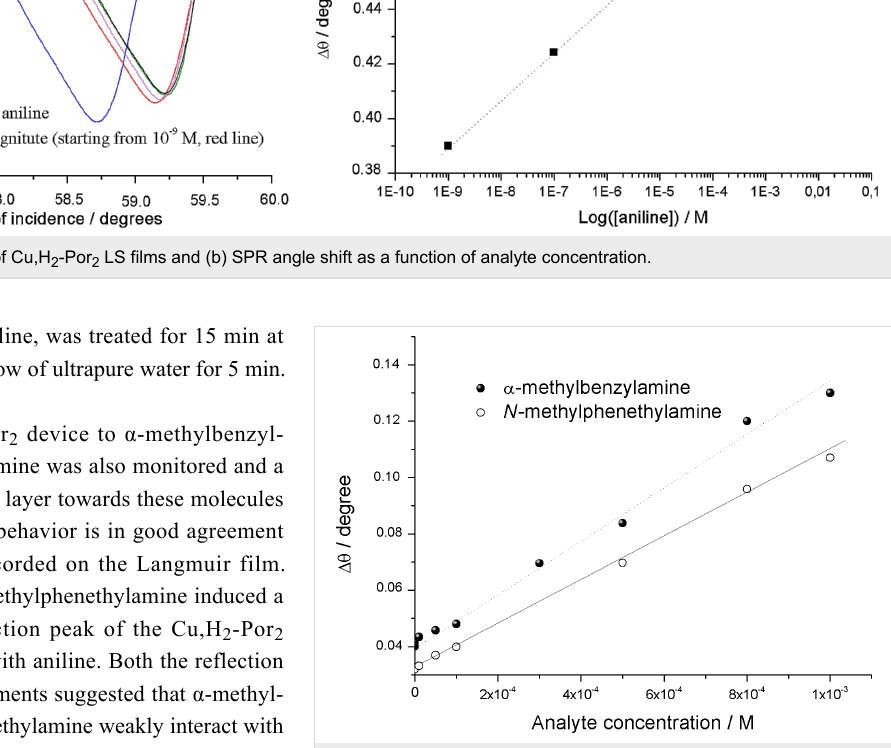
Figure 8: SPR angle shift as a function of α -methylbenzylamine (filled black circles) and N -methylphenethylamine (unfilled circles) concentra- tion in aqueous